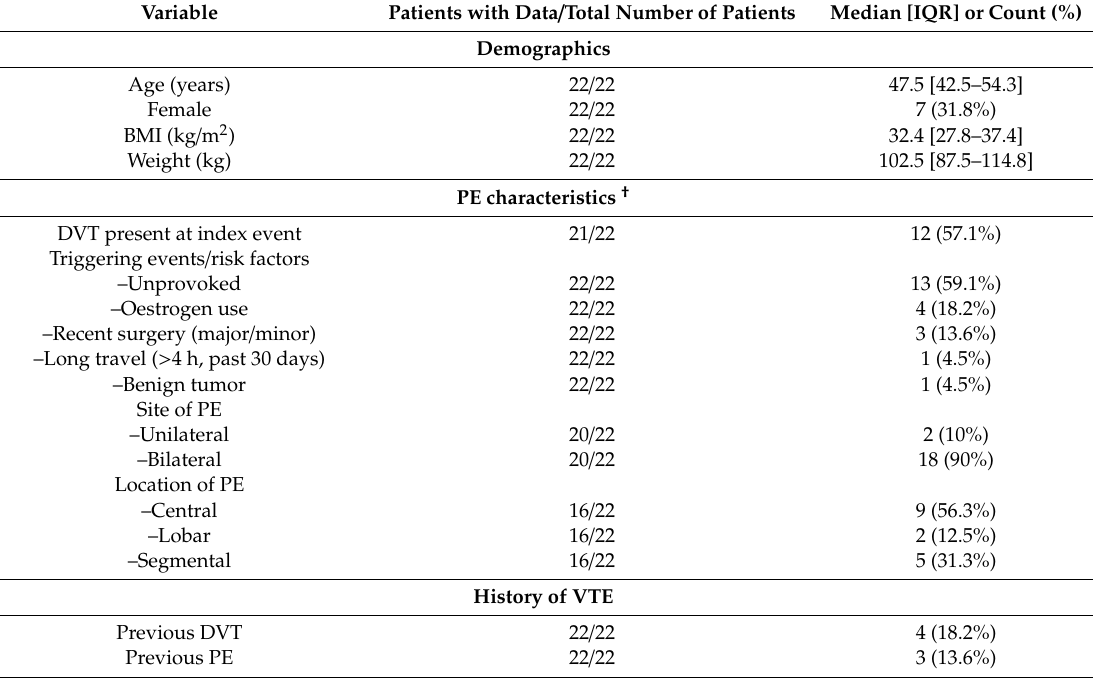
Table 1. Patient demographics, PE characteristics and time until pulmonary rehabilitation after PE.